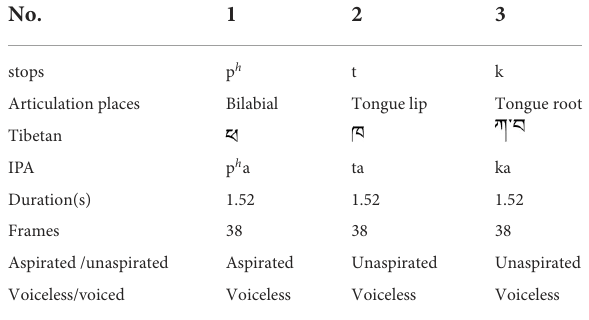
TABLE 2 Stops in Tibetan Xiahe